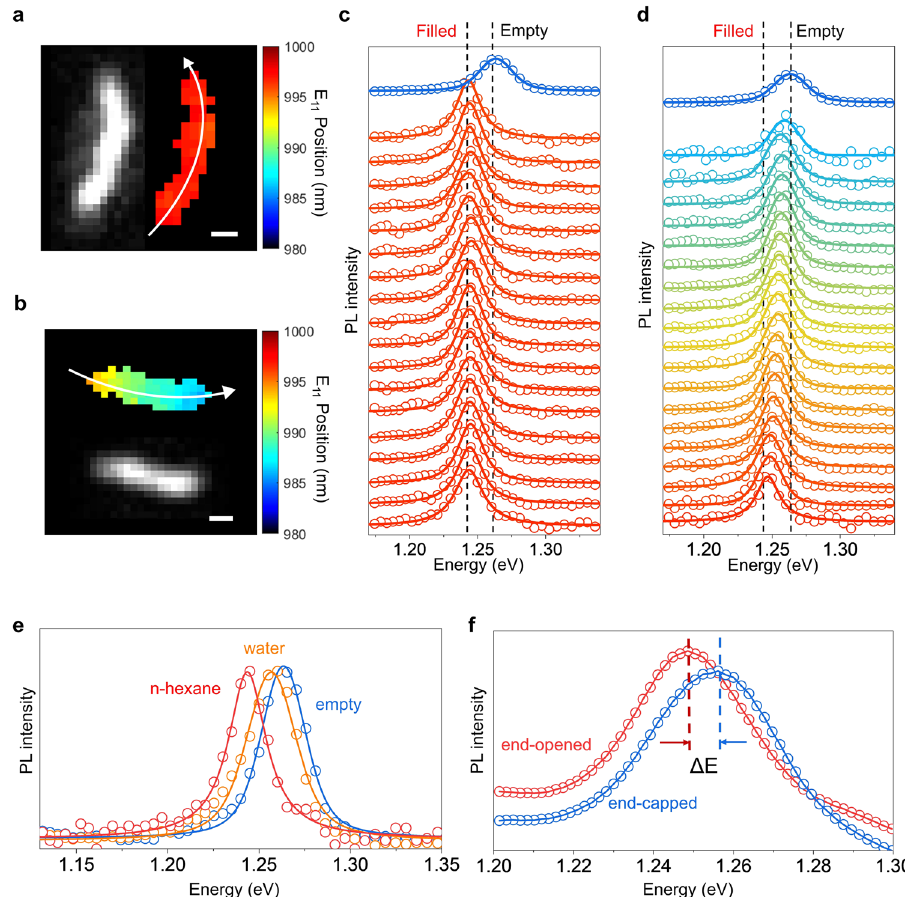
Fig. 2 Hyperspectral imaging and photoluminescence spectroscopy of alkane- fi lled individual SWCNTs. a Hyperspectral images of the E 11 PL from a single (6,5)-SWCNT that is fi lled with n-hexane along its length. Left: PL intensity image. Right: Map of the PL peak positions. b PL image of a (6,5)- SWCNT partially fi lled with n-hexane. Top: PL Peak position map. Bottom: PL intensity image. c PL spectra along the center of the n-hexane fi lled nanotube (indicated by the arrow in a ) in comparison with an empty control. d PL spectra along the center of the nanotube partially fi lled with n-hexane (indicated by the arrow in b ). e PL spectra from individual (6,5)-SWCNTs that are empty (blue), water- fi lled (orange), and n-hexane- fi lled (red). f Ensemble PL spectra of end-opened (red) and end-capped (6,5)-SWCNTs (blue) that had been incubated in n-hexane. Scale bars in a , b represent 500 nm. Note that in a , b , the peak position is from spectral fi tting of each data set with a Gaussian function. The other spectra are fi tted with a Voigt distribution